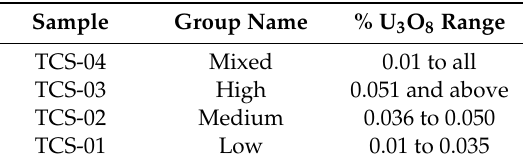
Table 2. Sample grouping.